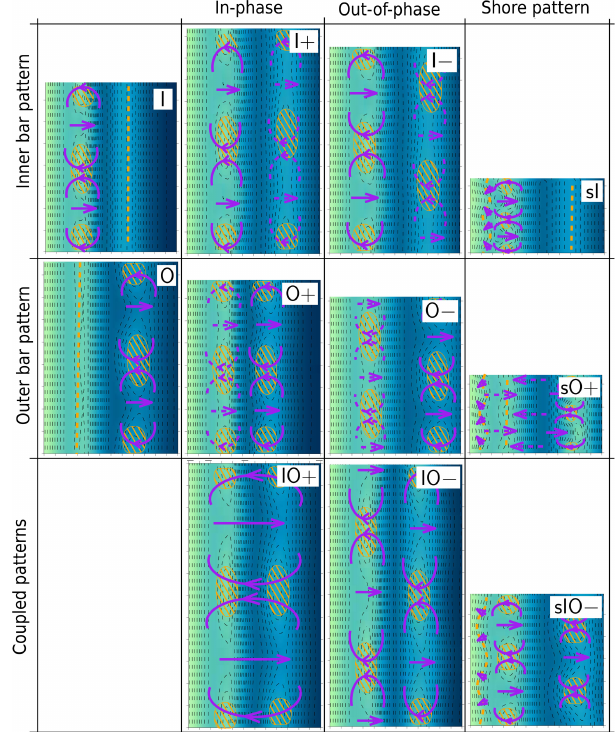
Figure 6. Morphological patterns obtained in this study. The let- ters I and O indicate a dominance of the inner and outer sandbars, respectively. Patterns indicated with the code IO represent modes where both sandbars are simultaneously unstable. The symbols + and – are used to indicate possible in-phase or out-of-phase cou- pling. Modes affecting shoreline and/or inner surf zone morphology have been indicated by the subscript s